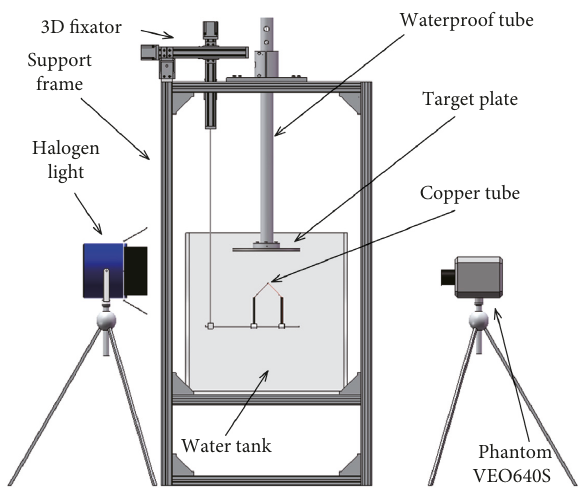
Figure 1: Schematic of the test